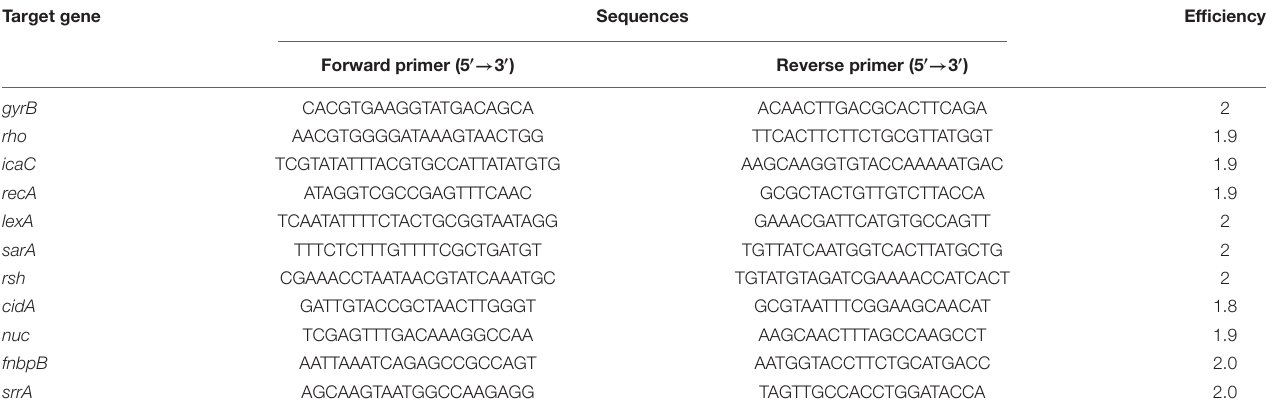
TABLE 1 | Nucleotide sequences of primers used for RT-qPCR and efficiency for each primer couple. Target gene Sequences